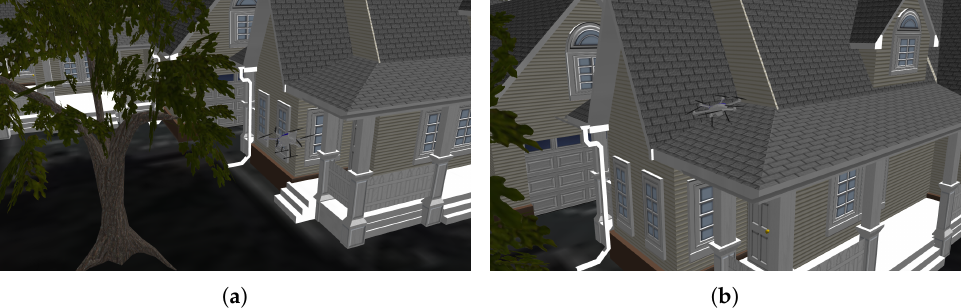
Figure 16. Unmanned Aerial Vehicles (UAV) interaction in Gazebo world: ( a ) scale view of drone in Las Vegas simulation relative to spawned elements; and ( b ) close-up of drone in Las Vegas simulation landing on building in